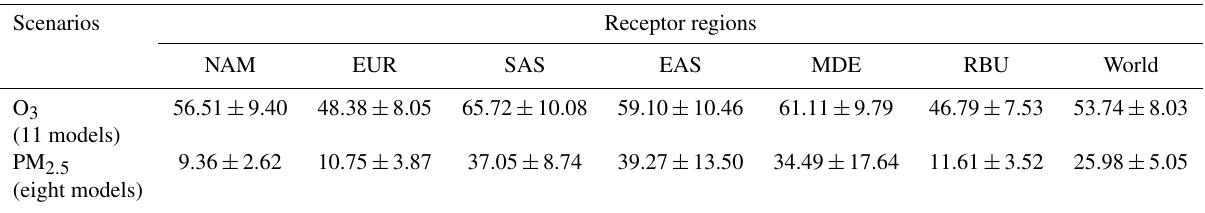
Table 1. Population-weighted multi-model mean O 3 (ppb) and PM 2 . 5 concentration (µgm − 3 ) for the 2010 baseline, for the 6-month O 3 season average of 1h daily maximum O 3 and annual average PM 2 . 5 , shown with the standard deviation among models.